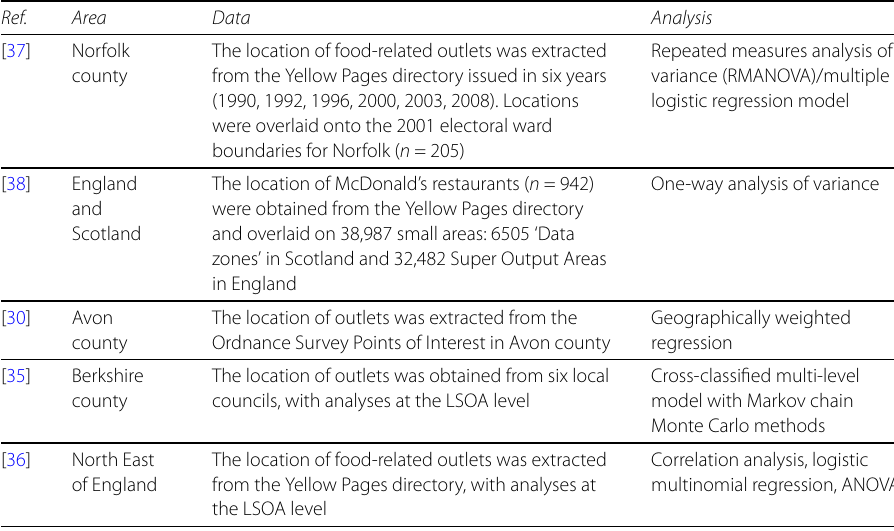
Table 3 Key features of previous studies of fast-food outlets in the UK Ref.